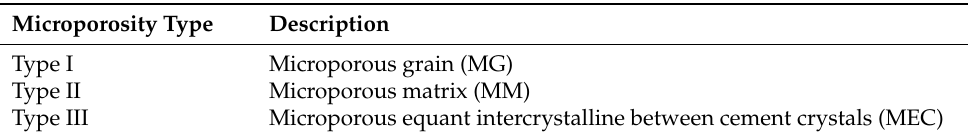
Table 1. Major types of microporosity in